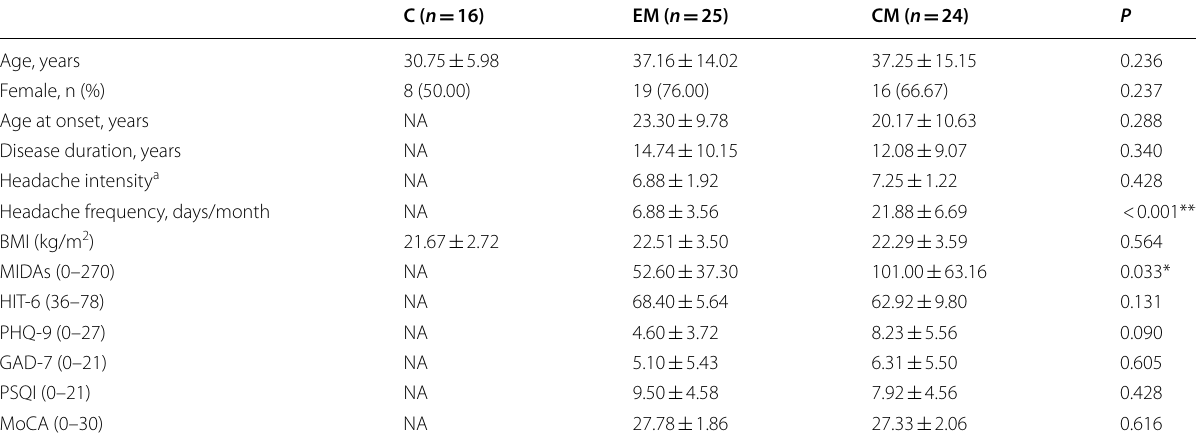
Table 1 Comparisons of demographics and clinical characteristics between episodic and chronic migraine patients and normal